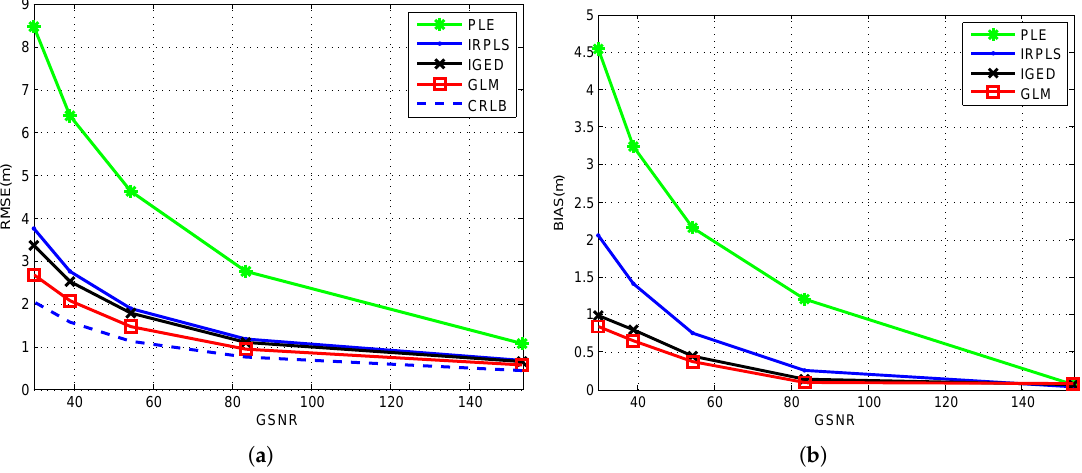
Figure 4. RMSE and bias performance comparison of PLE, IRPLS, IGED and GLM estimates with various GSNRs. ( a ) RMSE results. ( b ) Bias norm results.